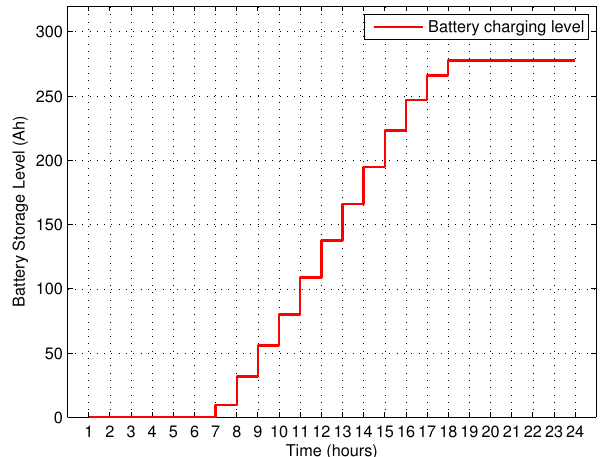
Figure 7. Charging behavior of Energy Storage System (ESS).